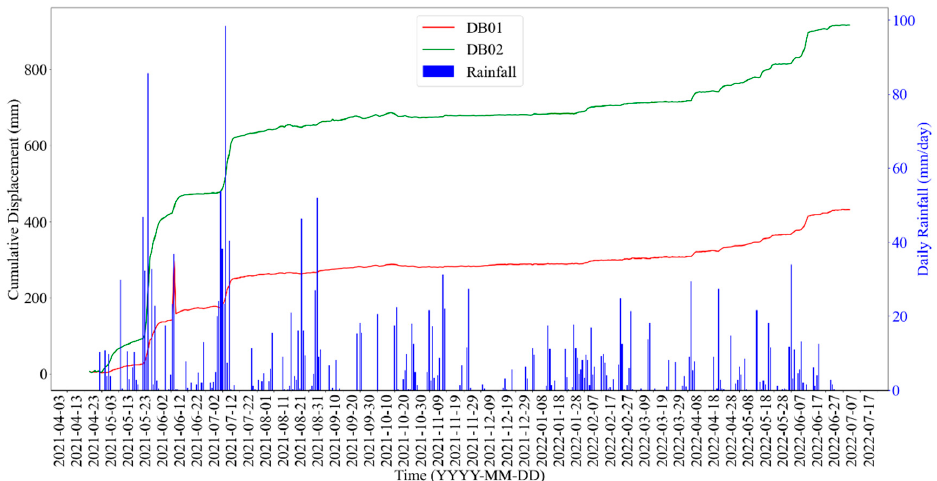
Figure 3. Daily rainfall data and displacement data from two GNSS monitoring stations for the Lishanyuan landslide.